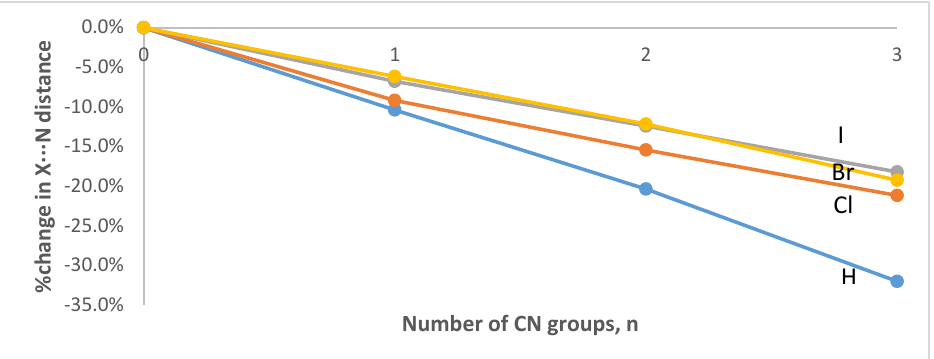
Figure 4. Percent change in the intermolecular X∙∙∙N distance as a function of the number of CN groups in the CH 3-n (CN) n X∙∙∙NMe 3 (X = H, Cl, Br, or I; n = 0–3) complexes optimized at the ωB97X-D/aug-cc-pVTZ level of theory.